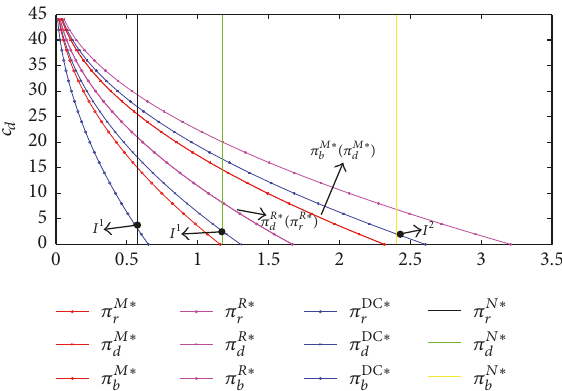
Figure 3: Effects of 𝑐 𝑑 on benefits of supply chain